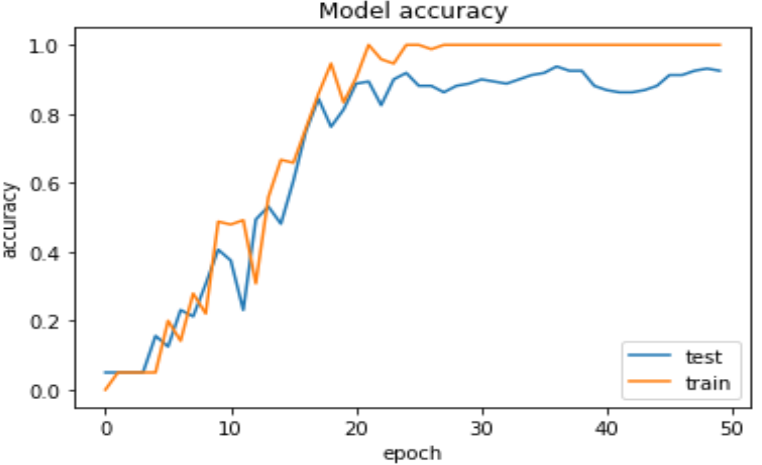
Figure 15. RFER-EADL training and testing accuracy.